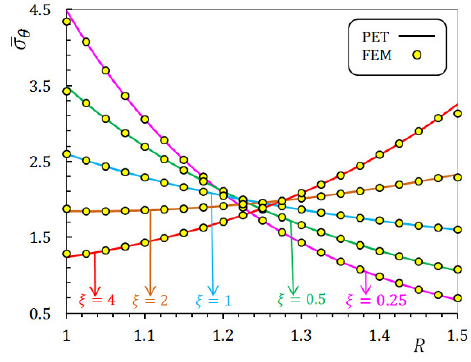
Figure 5. Radial distribution of circumferential stress ( η = 1 . 5) .